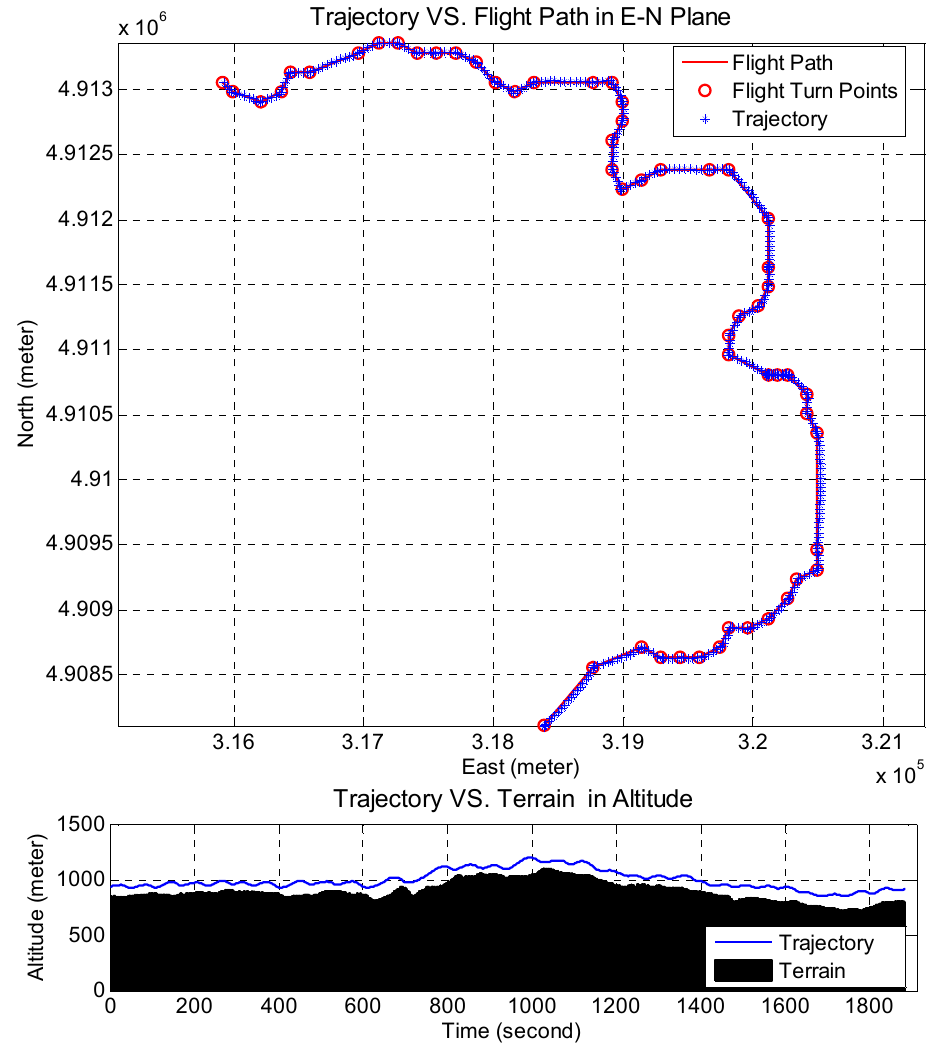
Figure 22. The upper sub-figure is the result in the East-North horizontal plane and the lower sub-figure is the altitude